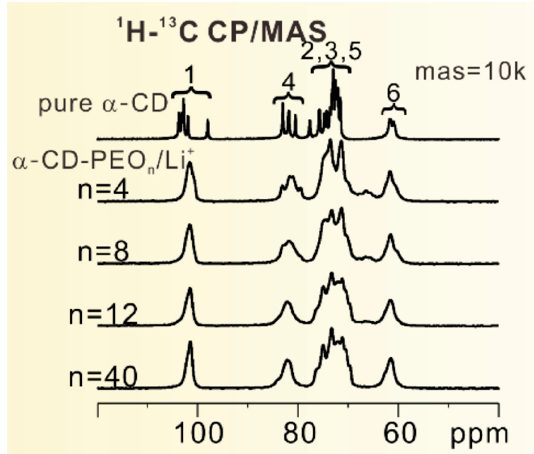
Figure 10. The disappearance of the signal splitting indicates the formation of α -CD-PEO inclusion complex [87] © 2018 WILEY-VCH Verlag GmbH & Co. KGaA, Weinheim. complex [87] © 2018 WILEY-VCH Verlag GmbH & Co. KGaA,